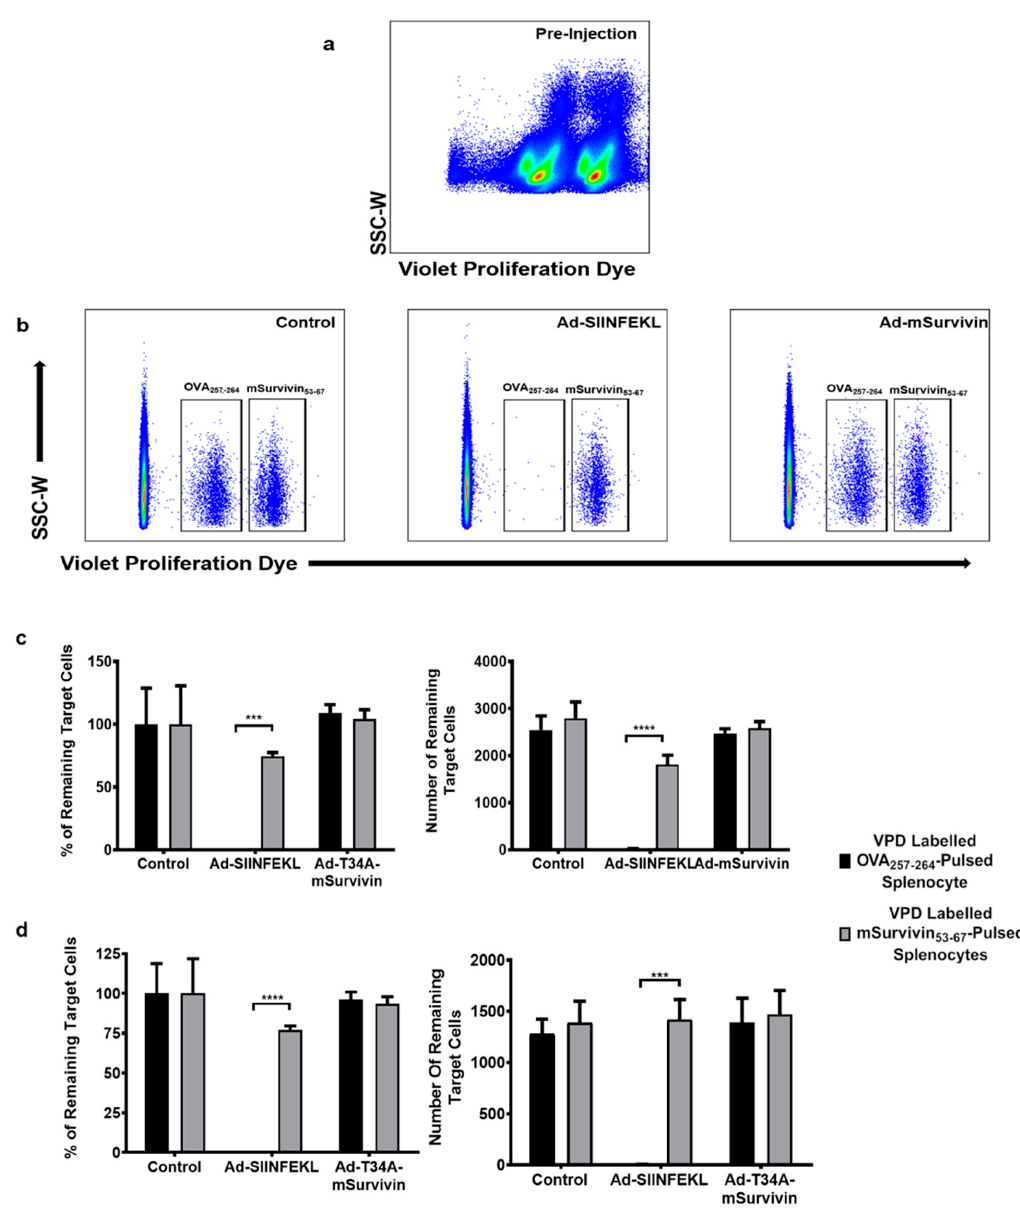
Figure 2. Vaccination against murine survivin was unable to induce a survivin-specific cytotoxic response. ( a ) Splenocytes from female C57BL/6 mice were split in two groups and stained with violet proliferation dye (VPD) at a concentration of 0.2 µ M or 1 µ M and pulsed with either OVA 257–264 (SIINFEKL, VPD lo ) or mSurvivin 53–67 (DLAQCFFCFKELEGW, VPD hi ) peptides. ( b ) Both sets of VPD-labelled target cells were injected into Ad-SIINFEKL-vaccinated, Ad48-T34A-mSurvivin- vaccinated, and control mice 10 days post-immunization. The adenovirus-treated mice were given 1 × 10 8 infectious units intramuscularly. The SIINFEKL-pulsed target cells were eliminated in the Ad-SIINFEKL-vaccinated mice, and were unaffected in the control, and survivin-vaccinated groups. mSurvivin 53–67 peptide-pulsed targets cells were not killed in the survivin-vaccinated group, nor the Ad-SIINFEKL-vaccinated or control groups. Percent of remaining (left) and total recoverable number (right) target cells graphically illustrate a cytotoxic immune response to SIINFEKL in the Ad-SIINFEKL- vaccinated group in the blood ( c ) and spleens ( d ). Survivin-specific target cells were not eliminated in any group. Two-way analysis of variance with Tukey’s multiple comparison test determined significance for the graphs showing the frequency (left) and number (right) of remaining VPD-labelled target cells. The frequencies were normalized to the recovery frequency values of each target subset in unvaccinated mice. *** = p ≤ 0.001; **** = p ≤ 0.0001; SSC-W = side